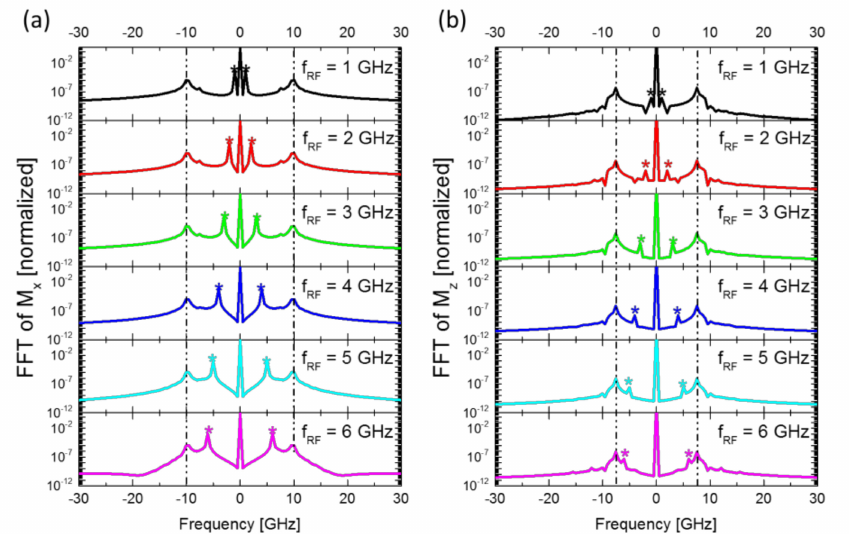
Figure 3. Effects of external RF magnetic field excitation. The effect of increasing excitation frequency of RF signal on ( a ) M x and ( b ) M z spectral peaks’ intensities and positions/frequencies, for 8–10 ns time window. The damping coefficient is kept at the value of 0.013 for all